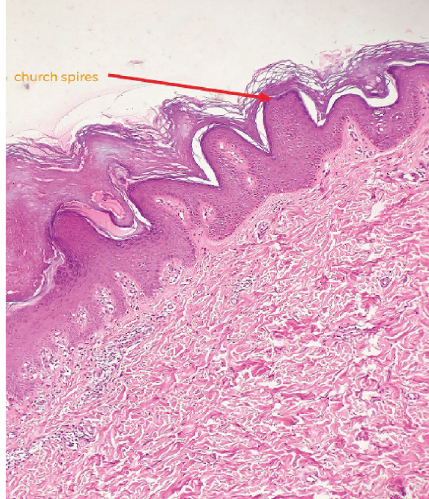
Figure 5: H&E stain with 10 × : focal areas of hyperkeratosis, papillomatosis, and acanthosis with church spire appearance in